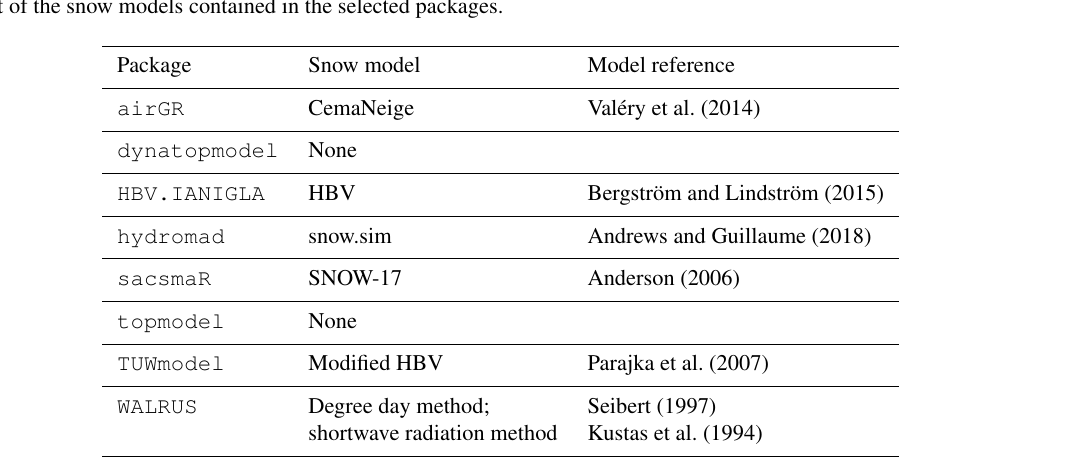
Table 2. A list of the snow models contained in the selected